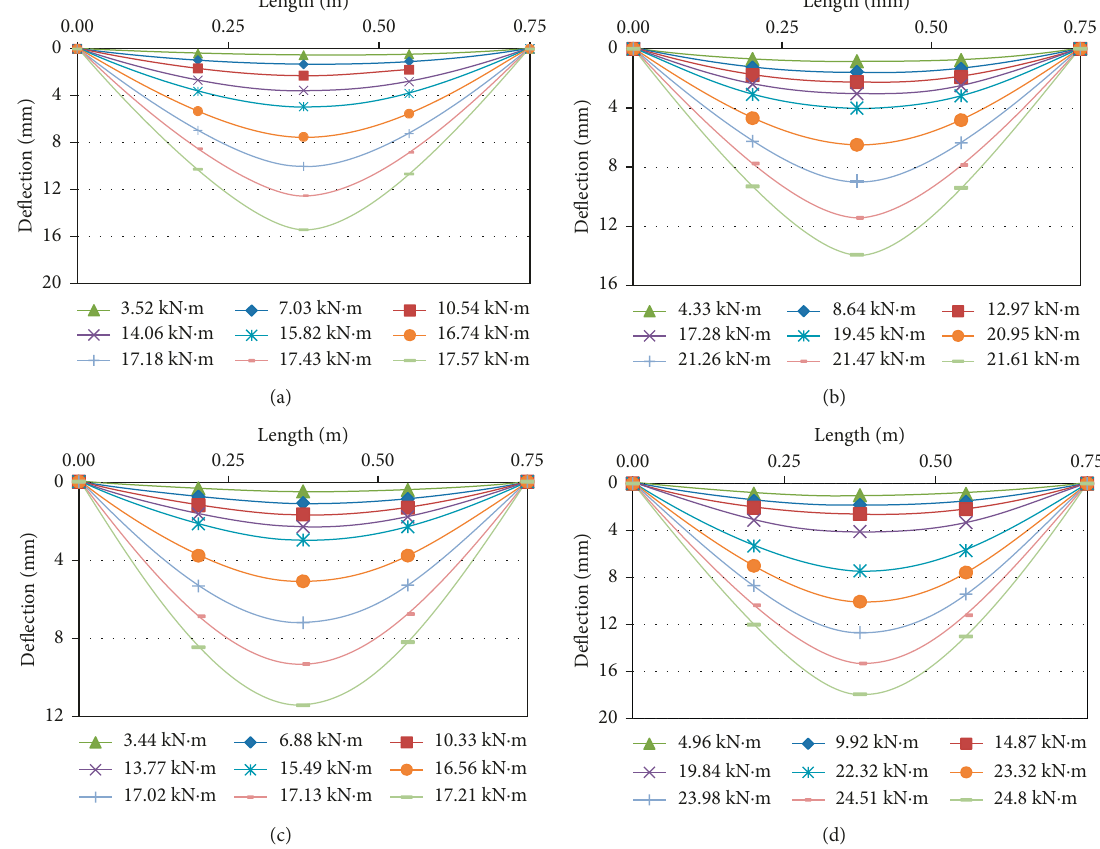
Figure 10: Deflection curves along different loading stages. (a) CB (control beam). (b) RB-FL-SB. (c) RB-PL-DB. (d) had almost identical failure modes regardless the difference of retrofitting scheme (single or double bottom steel plates).